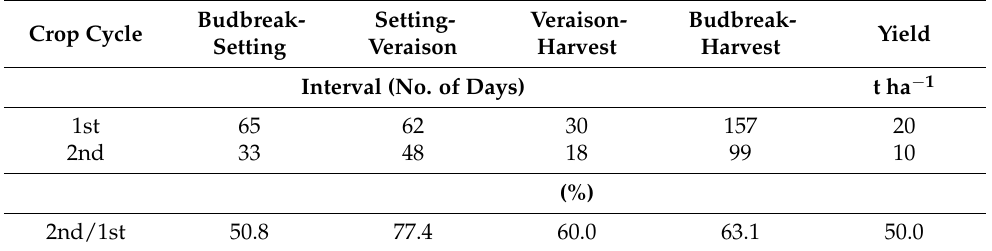
Table 5. Phenological stage intervals (number of days) in the 1st (winter–spring) and 2nd (summer– autumn) cropping cycle and yield (t ha − 1 ) of ‘Matilde’ table grape under conventional soil-grown greenhouse cultivation at a planting density of 1111 plants per hectare z . Budbreak- Crop Cycle